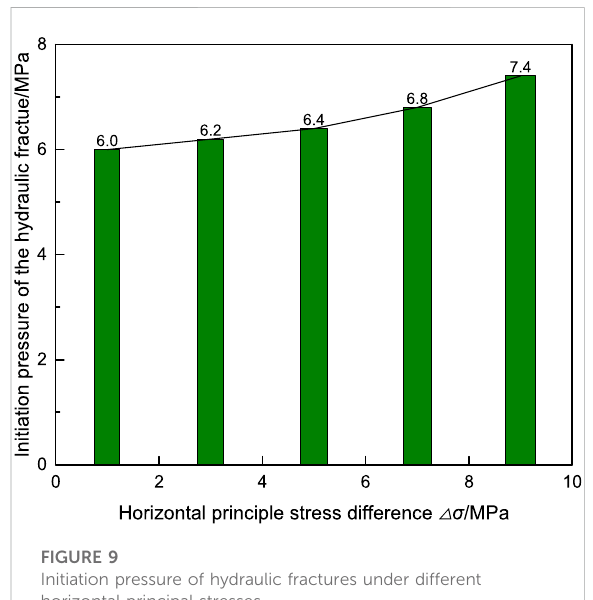
FIGURE 9 Initiation pressure of hydraulic fractures under different horizontal principal